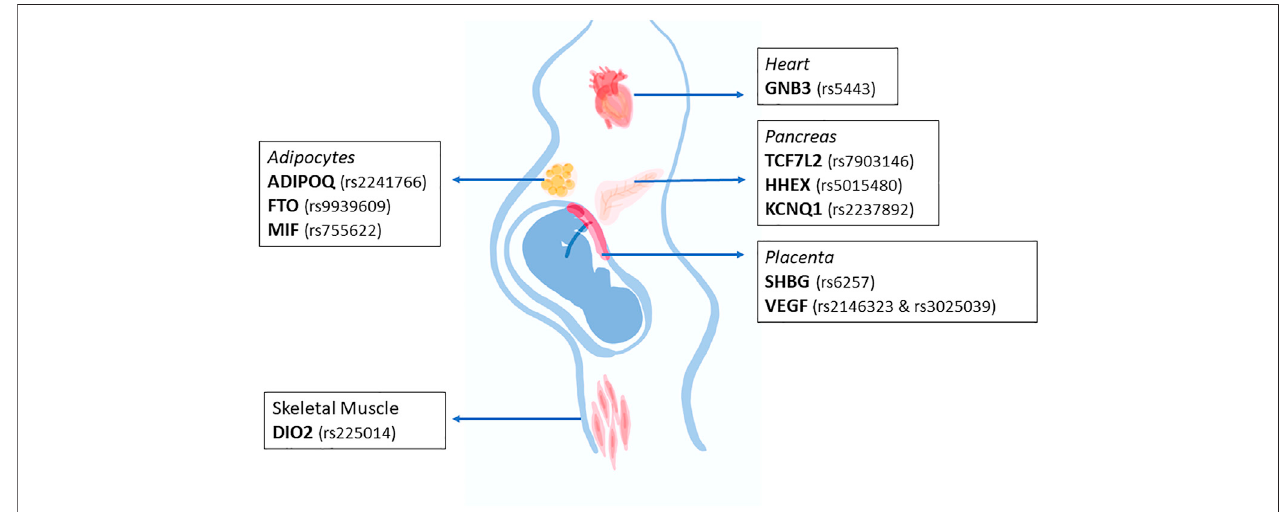
FIGURE 1 | Major organs affected by the main SNPs associated with gestational diabetes mellitus. The main organs affected by the SNPs described in this review are heart, adipose tissue, pancreas, and skeletal muscle. Interestingly, the SNPs described would affect some functions in the indicated organ, favoring the onset of gestational diabetes